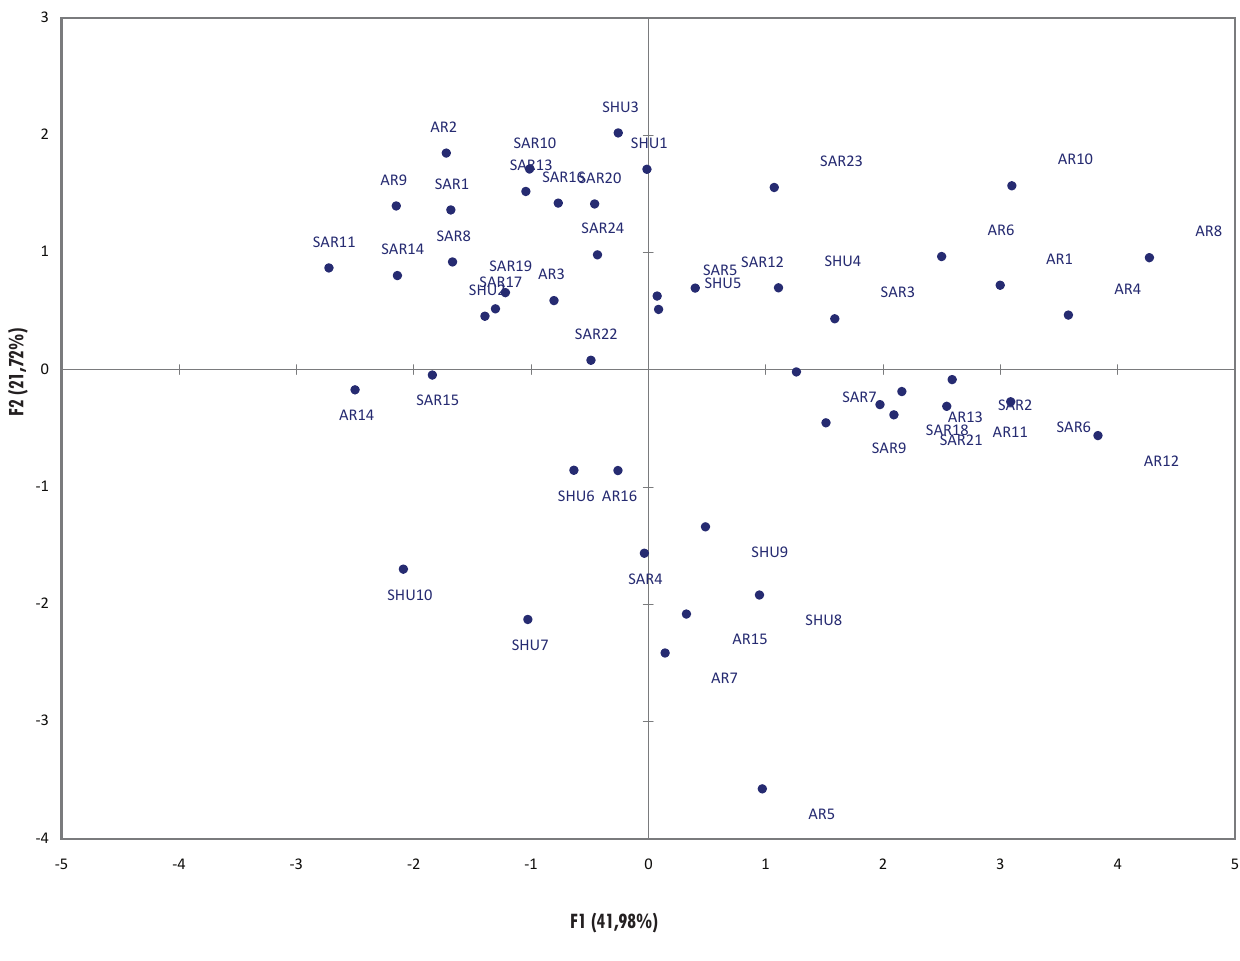
Biplot (axes F1 et F2: